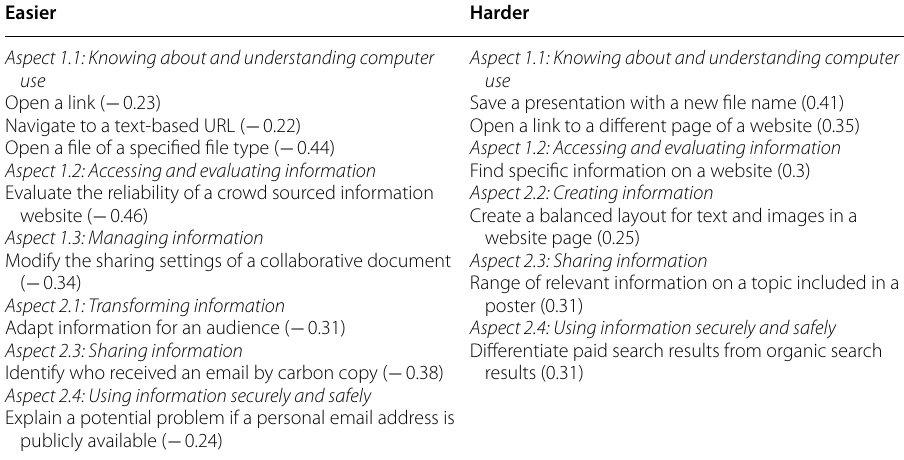
Numbers in parenthesis are the DIF values